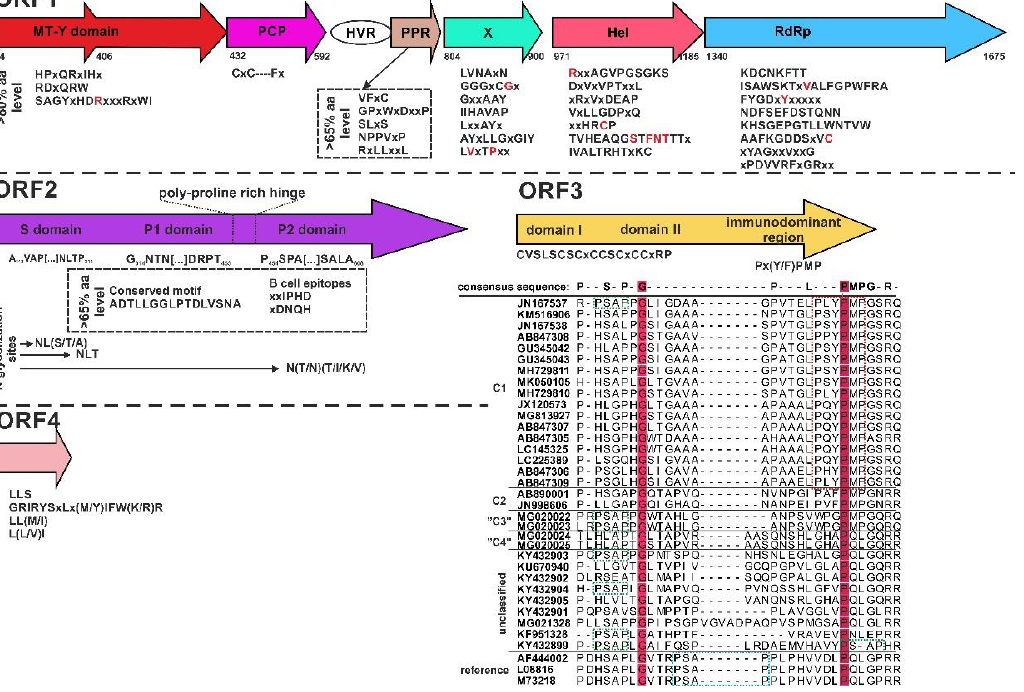
Figure 2. Schematic organization of the encoded polyproteins (ORF1, ORF2, and ORF3) and the putative (ORF4) protein in rodent origin hepevirus genome. The ORF1 is coding the non-structural proteins, sequentially the MT-Y: methyltransferase domain; PCP: papain-like cysteine protease domain; HVR: hypervariable region; PPR: poly-proline region; X: macro domain; Hel: helicase enzyme; RdRp: RNA-dependent RNA polymerase. The amino acid (aa) number positions are based on reference HEV-1 Burma strain. The conserved aa motifs in each ORFs were analyzed by GeneDoc using 65–80% aa conservation level set-up. The conserved aa is colored by black, the different aa is highlighted by red, and x means any aa in the motifs of rodent hepevirus ORF1. The S-, P1-, and P2 domains of ORF2-encoded viral capsid protein and the two main domains with the potential immunodominant region in ORF3-encoded protein are also identifiable in rodent hepeviruses. The immunodominant sites are emphasized by red, blue, and green dotted lines. The putative ORF4 in rodent hepevirus is not homologous with ORF4 of species Orthohepevirus A , but the conserved aa motifs are presented in the figure. The comparative analysis was based on the reference HEV-1 Burma strain (M73218), but other references, HEV-1 strain, Xinjiang (L08816), and strain Sar-55 (AF444002), were also involved in the analysis. Complete HEV-C1 strains used in this analysis: ratIDE079F